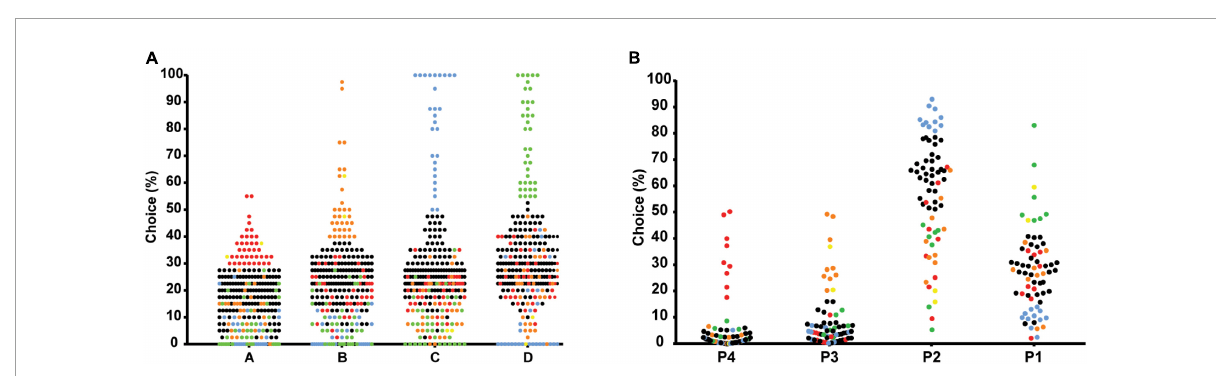
FIGURE5 Scatterplots of the percentage of individual deck choices during trials 61-100 in the IGT (A) , and during week 5 of the rGT (B) , separating the most extreme individuals in each choice using mean ± 1 standard deviation. The most extreme individuals in each choice of the IGT (A) are colored as follows: high A-red, high B-orange, high C-blue, high D-green, high in both A and B-yellow, intermediates-black. The most extreme individuals in each choice of the rGT (B) are colored as follows: high P4-red, high P3-orange, high P2-blue, high P1-green, high in both P1 and P3-yellow, and intermediates-black.